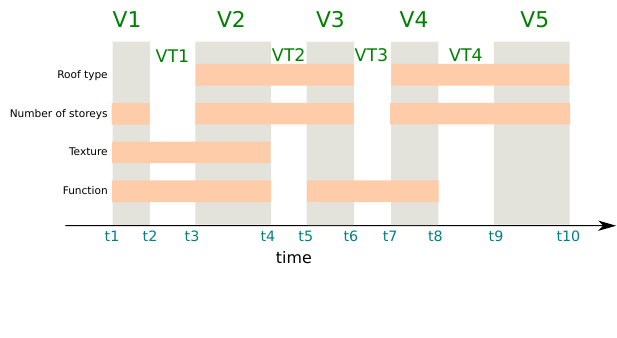
Figure 2. Change in features of a building. Every version V1-V5 has an associate existence time shown on the timeline. Versions are shown by grey vertical boxes. The validity of existence of a feature value is shown by the light-orange